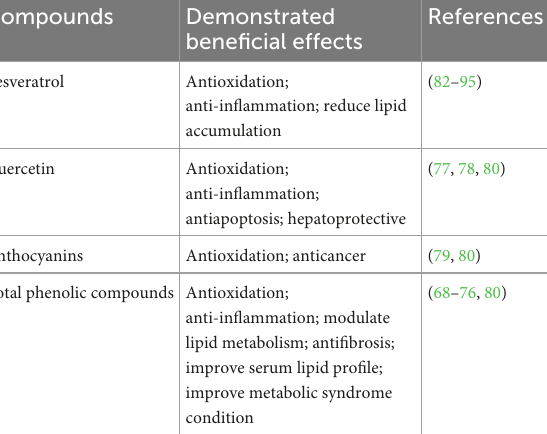
TABLE 2 Bioactive flavor compounds in wine and their beneficial